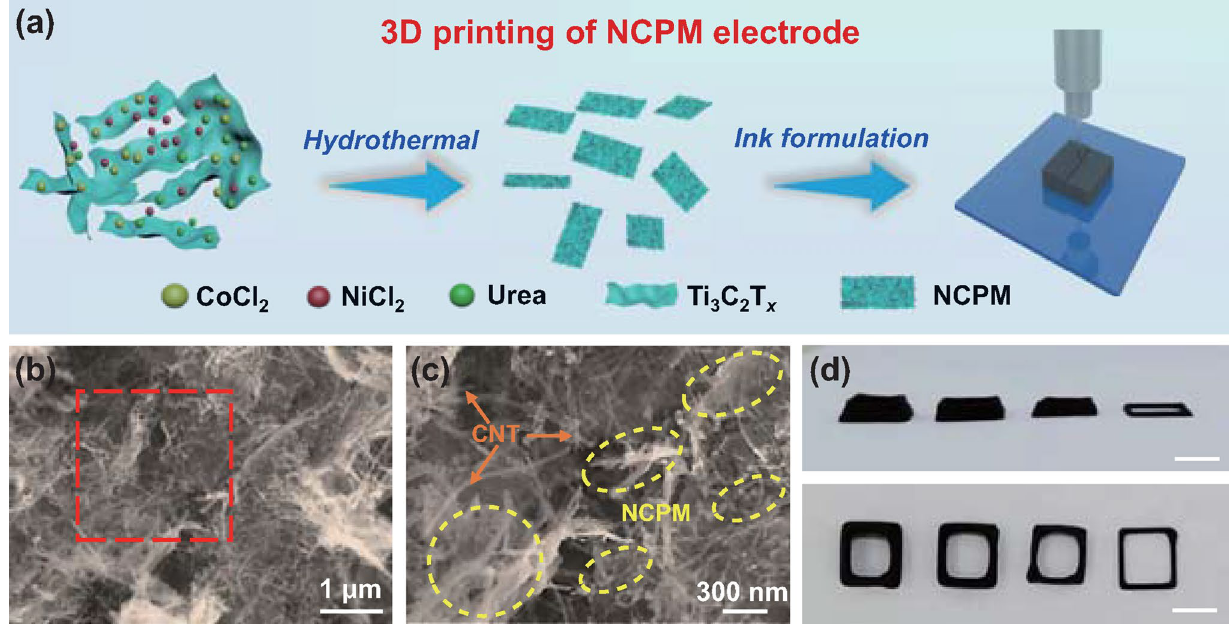
Fig. 1 a Schematic illustration showing the NCPM synthesis and the 3D printing process. b , c SEM images of the NCPM composite ink. d Digital photos showing printed hollow square lattices with increasing wall thickness. Scale bar: 8